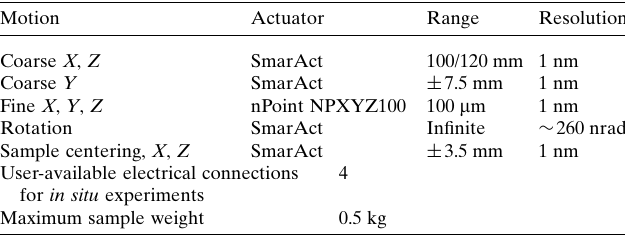
Table 3 Summary of all motions of the sample stage.